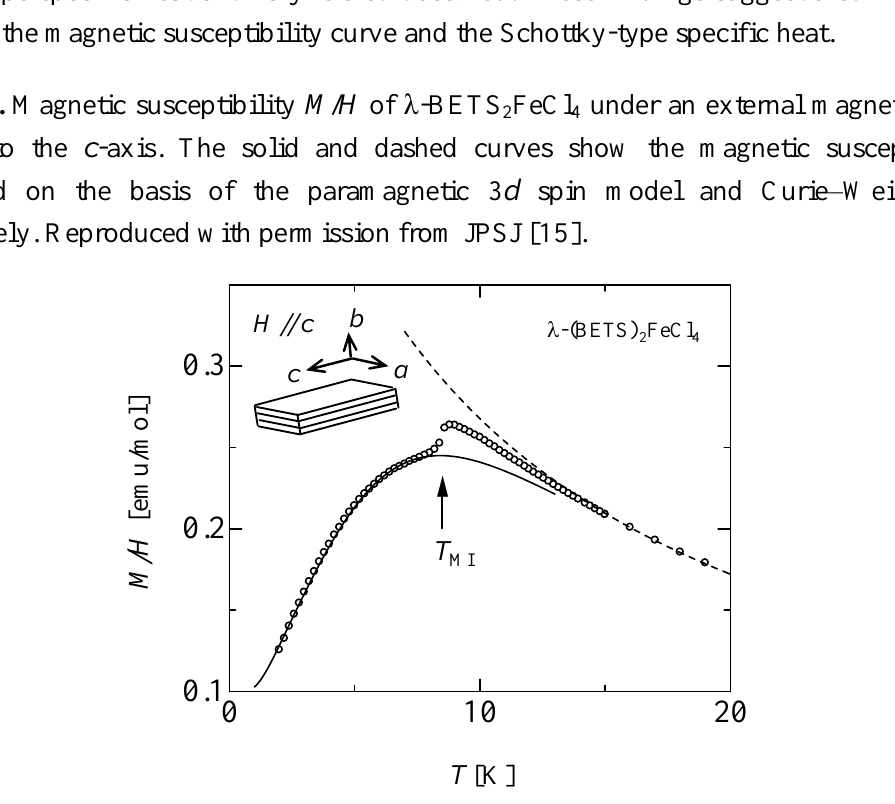
FeCl under an external magnetic field 2 4